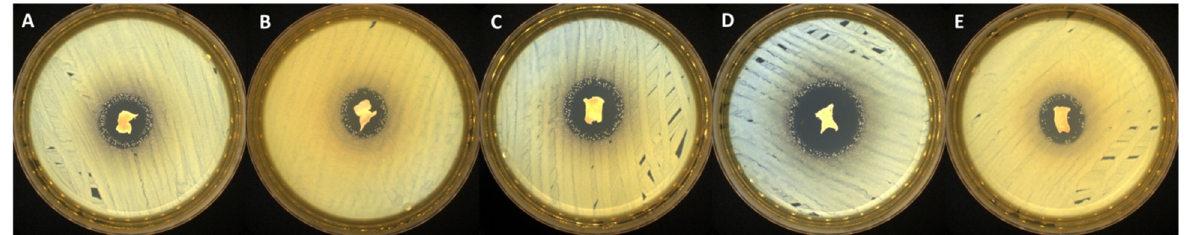
Figure 5. Antibacterial activity of the tested samples: ( A ) PVA_PEBSA 25/75 _Thy_ α -Tcp, ( B )